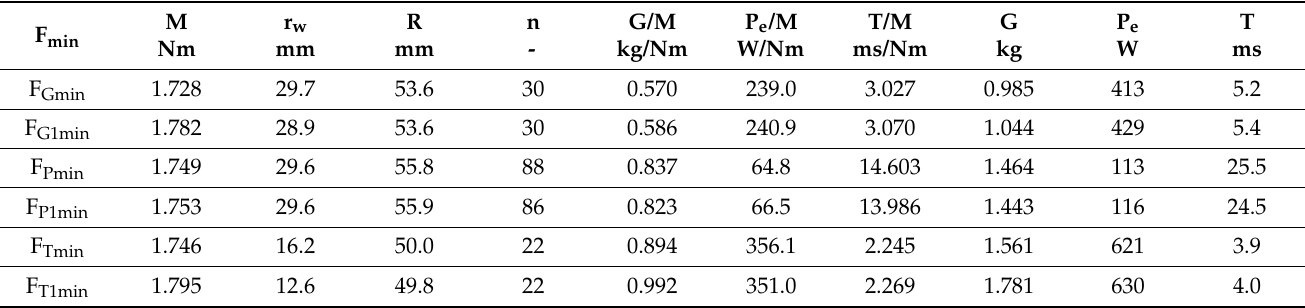
Table 7. PHB optimization results for 1.700 Nm < M < 1.800